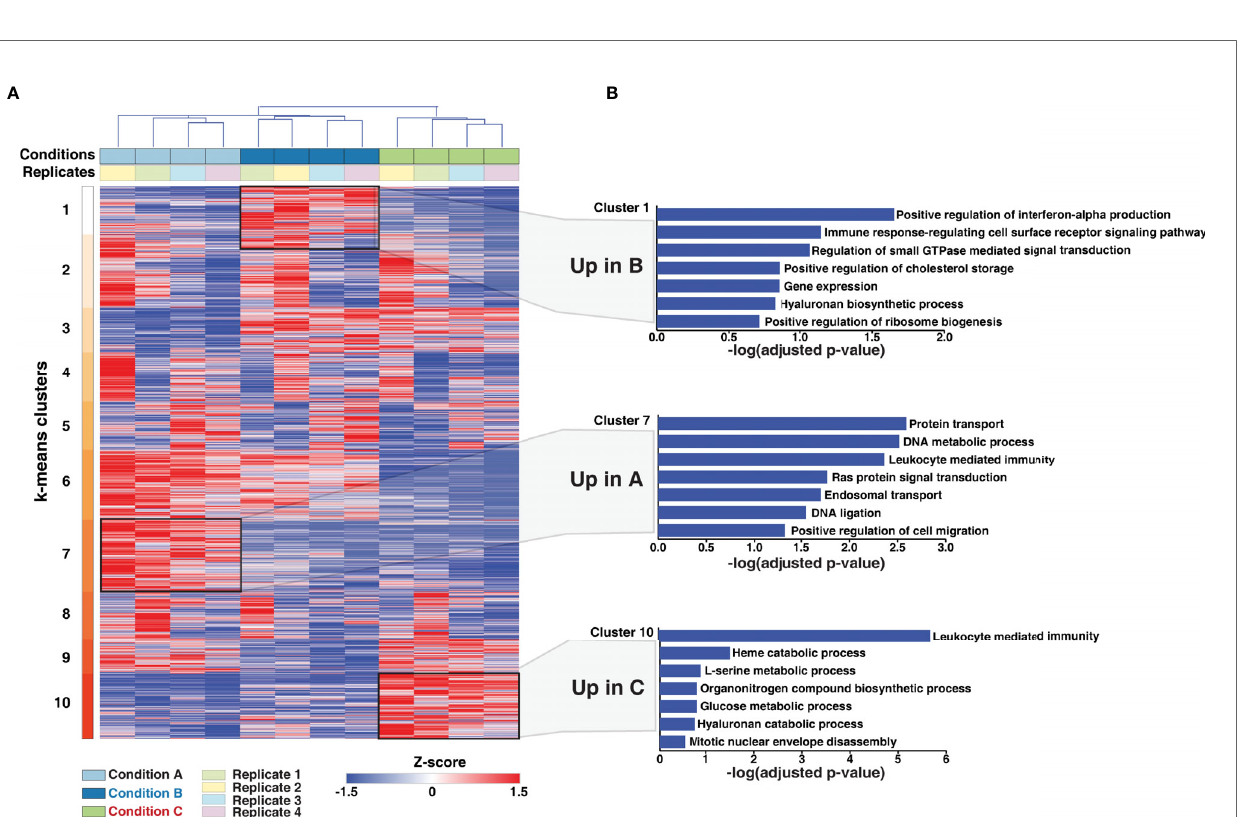
FIGURE 3 | Protein expression dynamics analysis upon PMA induced monocyte to macrophage differentiation. (A) Protein expression patterns in response to differentiation protocols A-C were analyzed. Log2 transformed, z-score normalized and scaled expression of proteins identi fi ed and quanti fi ed in all replicates were plotted, and k-means clustering was carried out. Clusters 1, 7, and 10 represent overexpressed proteins exclusive to conditions A-C, indicating induction of differentiation-protocol-speci fi c proteome signatures. (B) The proteins exclusive to each condition were subjected to Gene Ontology (GO) analysis using Enrichr to understand their function. Selected signi fi cantly enriched GO terms (biological processes) (p-value<0.005) have been highlighted. Notably, proteins involved in several metabolic processes were largely enriched in Condition C compared to the other two conditions tested. Overall, the primary cellular process of macrophages, i.e., mediating immune response is enriched in all three conditions